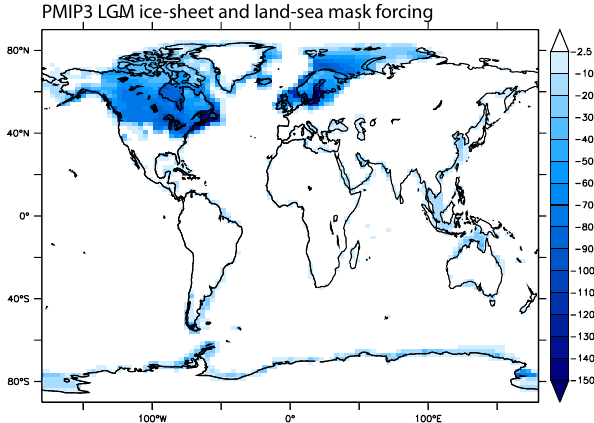
Figure 6. Estimation of the difference in radiative forcing (Wm − 2 ) at the LGM compared with pre-industrial conditions caused by im- position of the CMIP5/PMIP3 ice sheet and the change in the land– sea mask. The map is a composite of the results from five ocean– atmosphere models showing the spatial patterns of the change in to- tal forcing associated with the expanded Northern Hemisphere ice sheets at the LGM and with the increase in land area due to a low- ered sea